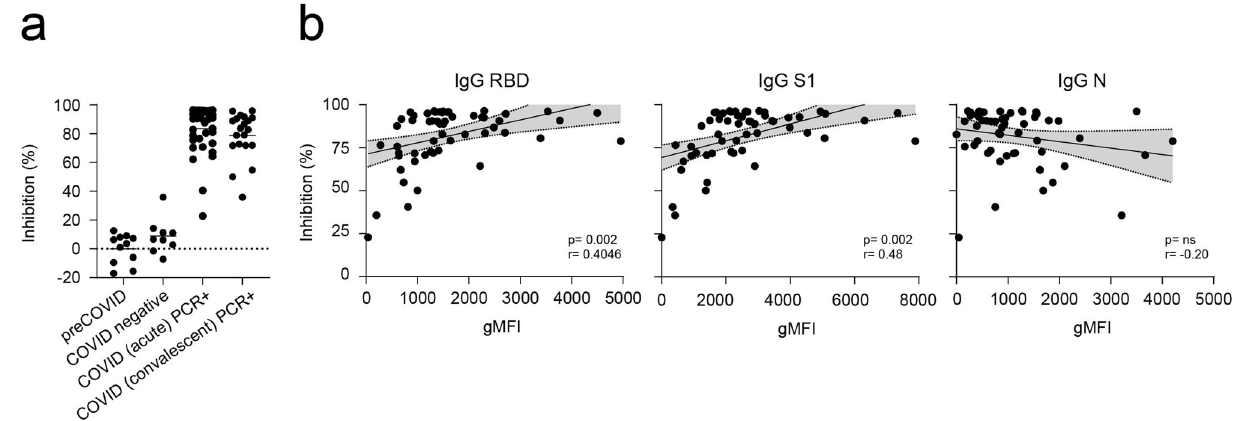
Fig. 7 Levels of anti-RBD and anti-S1 IgG antibodies measured by C19BA correlate with neutralization capacity of serum samples. a Neutralization assay performed on samples from different cohorts of individuals as indicated, including healthy and seropositive donors ( n = 77). b Correlation of gMFI values obtained by C19BA and % Inhibition obtained by the neutralization assay for anti-RBD IgG (left), anti-S1 IgG (middle), and anti-N IgG (right) ( n = 56). Pearson correlation coef fi cients ( r ) and their corresponding p values